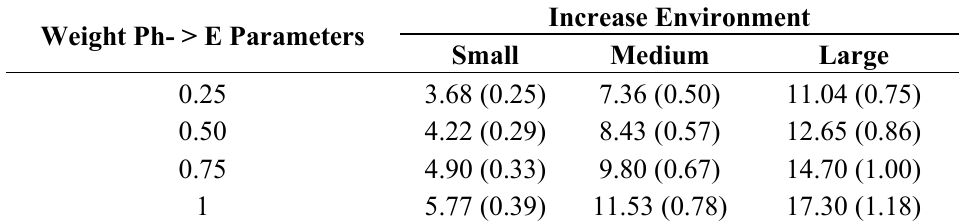
Table 6. Raw phenotypic mean changes (std units) of FSIQ as a function of weight given to the Ph->E transmission parameters ( w = 0.25, 0.50, 0.75) and different environmental αγ means. Environmental means at t = 1 is defined as a function of standard deviation of FSIQ (sd = 14.7, Small = sd * 0.25, Medium = sd * 0.50 and Large = sd * 0.75). FSIQ FSIQ FSIQ FSIQ Environmental means at t + 1 are calculated according to Equations (14) and (15).